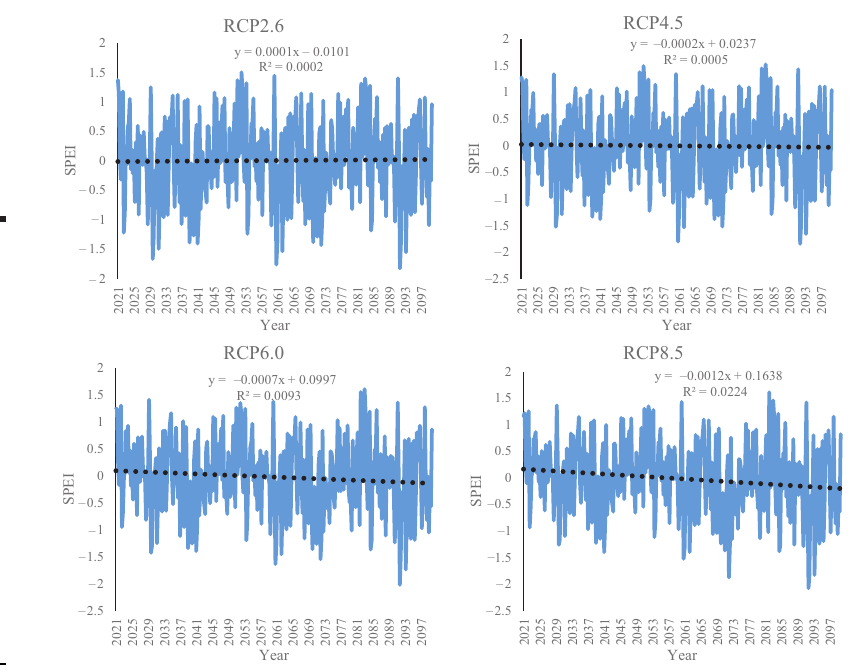
Figure 5. The change trend of seasonal SPEI in the Yellow River Basin under four RCP